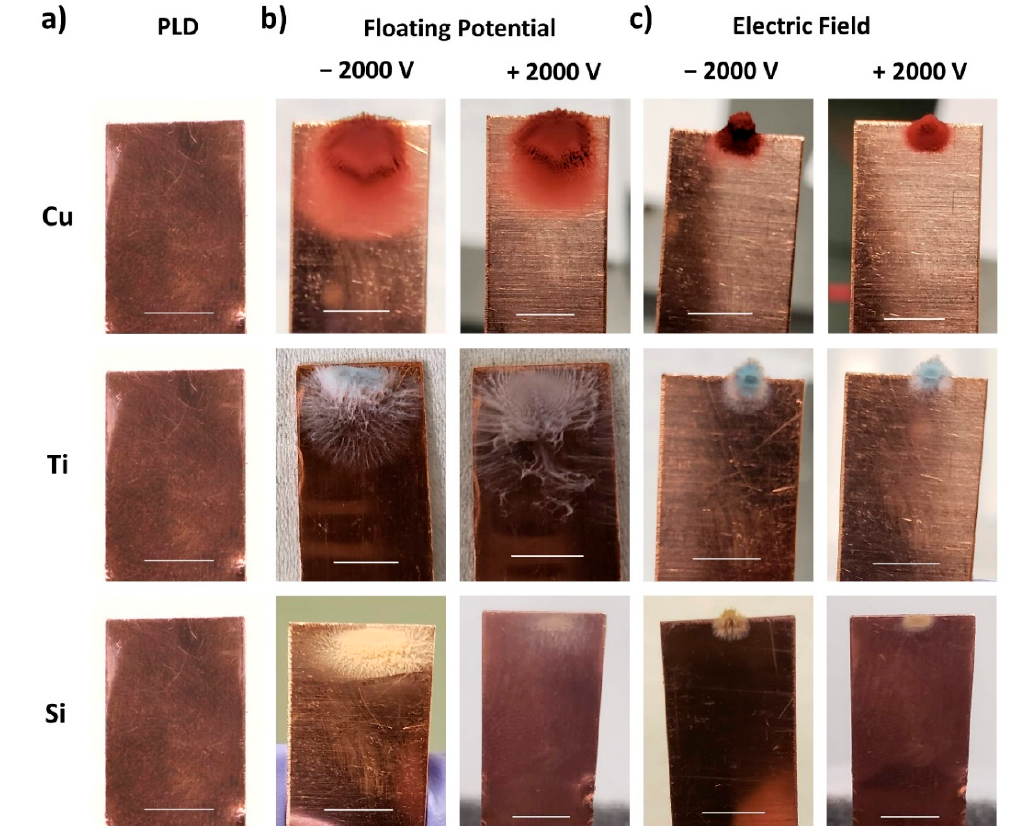
Figure 3. Photographs of the Cu collection plate after the process of laser machining in the parallel laser scanning direction under ( a ) conventional PLD, ( b ) floating potential, and ( c ) external electric field. The scale bars correspond to 5 mm.